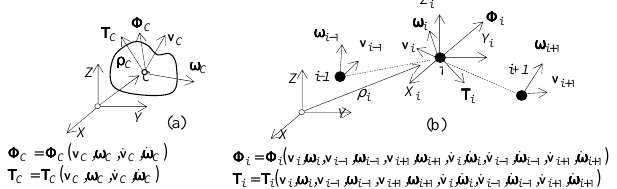
Figure 3. Inertia forces in a rigid body and nodes of finite elements